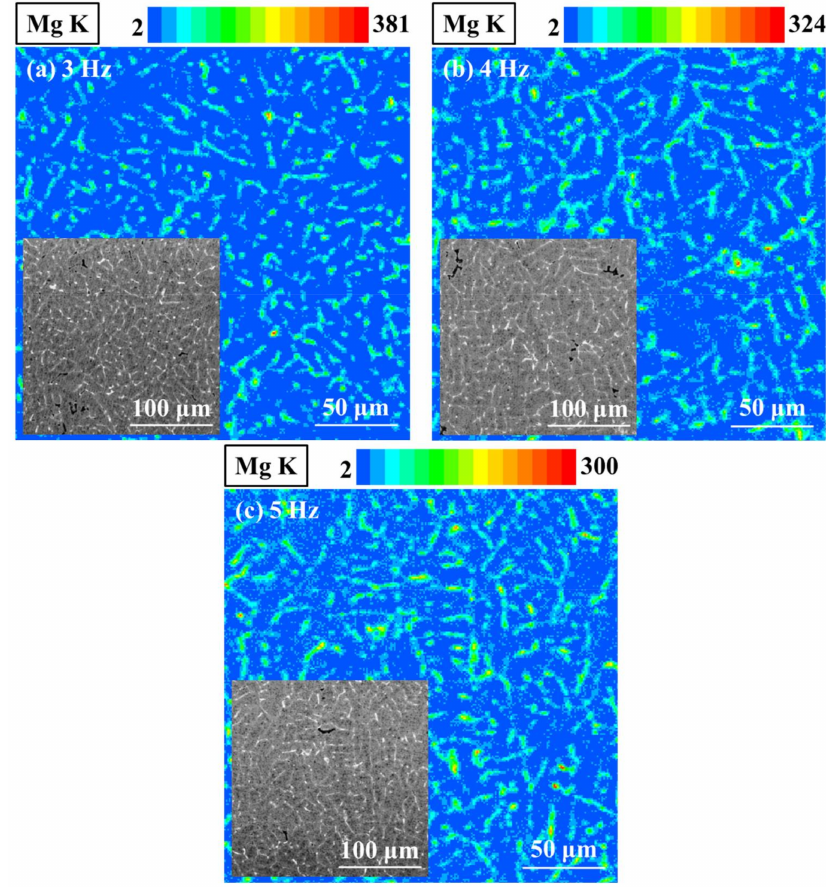
Figure 8. Energy dispersive spectrometer (EDS) maps of Magnesium elemental in fusion